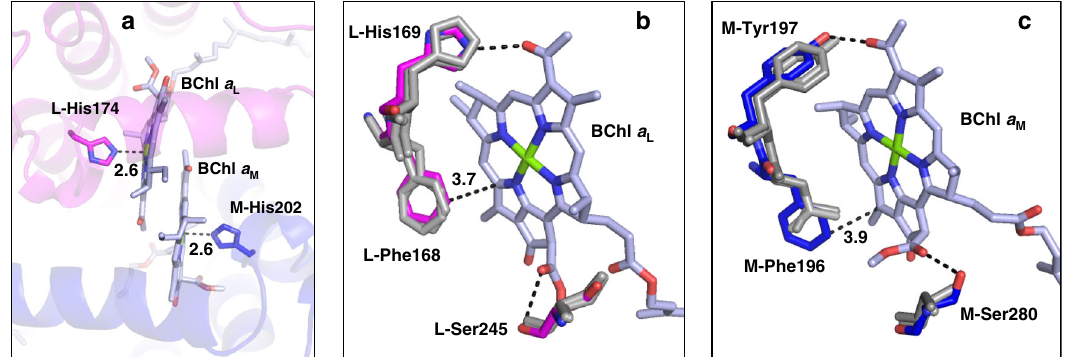
Fig. 4 Key residues around the Trv . strain 970 RC special pair BChl a dimer. a Top view of the BChl a dimer whose central Mg atoms are coordinated by the His residues in the L- and M-subunits. b Superposition of the residues in the RC L-subunits of Trv . strain 970 (magenta), Tch. tepidum (gray), and Rba. sphaeroides (gray) that form hydrogen bonds or interact with the BChl a molecule. c Superposition of the residues in the RC M-subunits of Trv . strain 970 (blue), Tch. tepidum (gray), and Rba. sphaeroides (gray) that form hydrogen bonds or interact with the BChl a molecule. All distances are in